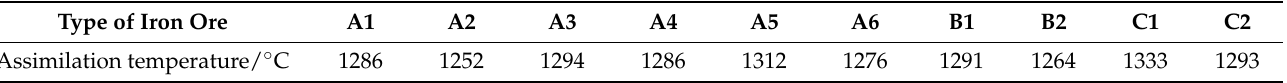
Table 5. Minimum assimilation temperature ( ◦ C).